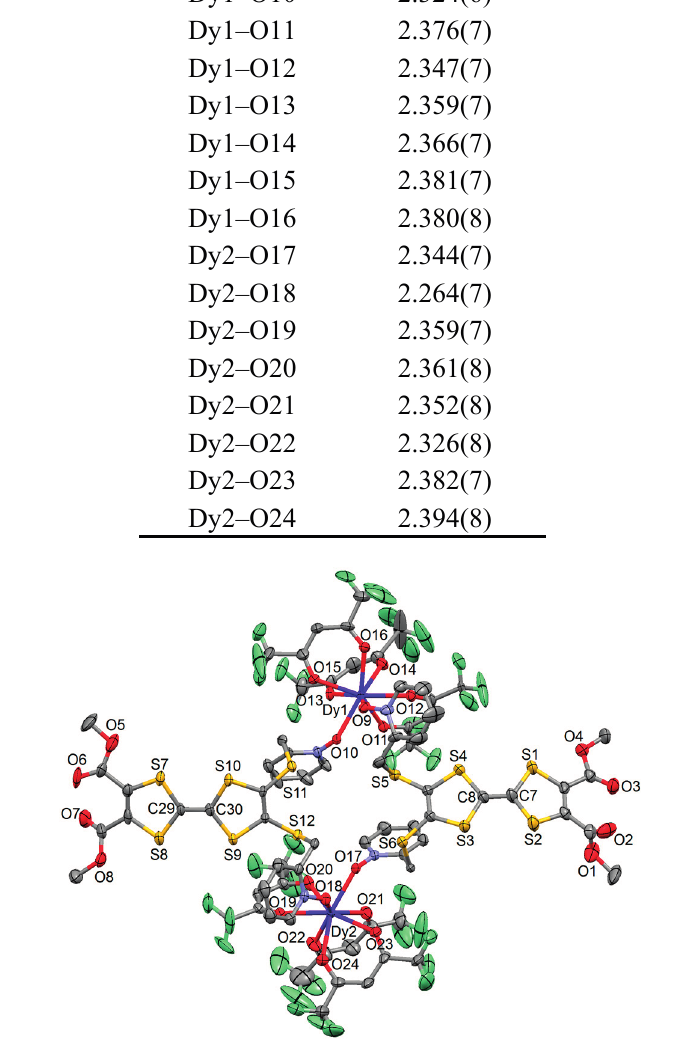
Figure 1. ORTEP view of 1 ([Dy 2 (hfac) 6 (L) 2 ]·(CH 2 Cl 2 )·0.5C 6 H 14 ). Thermal ellipsoids are drawn at 30% probability. Hydrogen atoms and solvent molecules of crystallization are omitted for